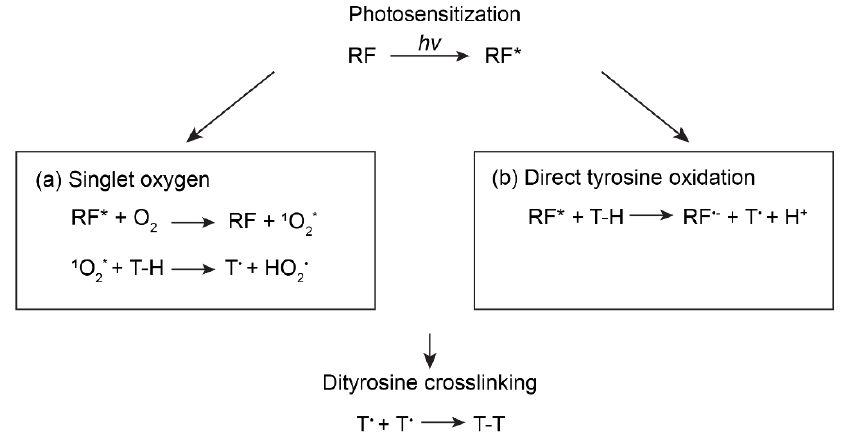
Figure 4. Photo-crosslinking mechanisms of riboflavin (RF). Upon light exposure, RF becomes photo-sensitized (RF*). ( a ) RF* reacts with dissolved oxygen to generate singlet oxygen ( 1 O 2 *) that further gives rise to tyrosine radicals (T • ). Reproduced with permission from Reference [92]. Copyright 2020